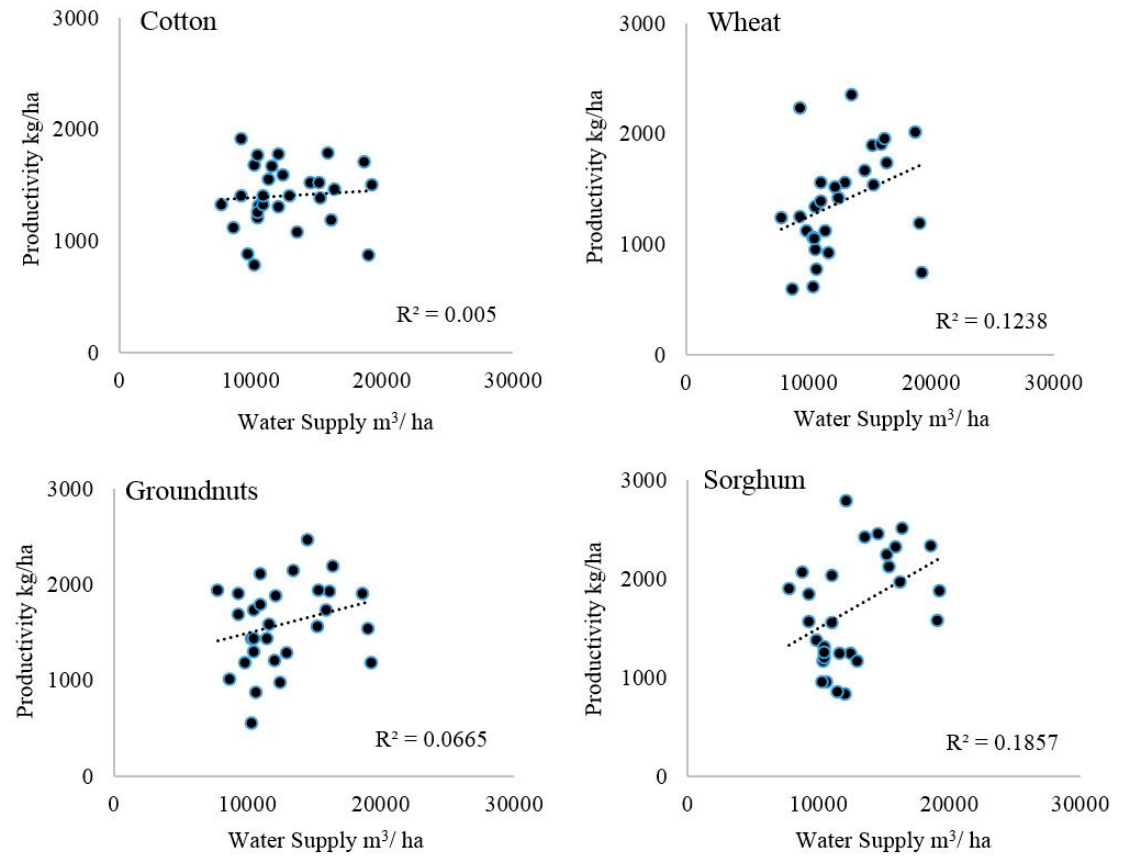
Figure 10. The relationship between water supply and crop productivity.